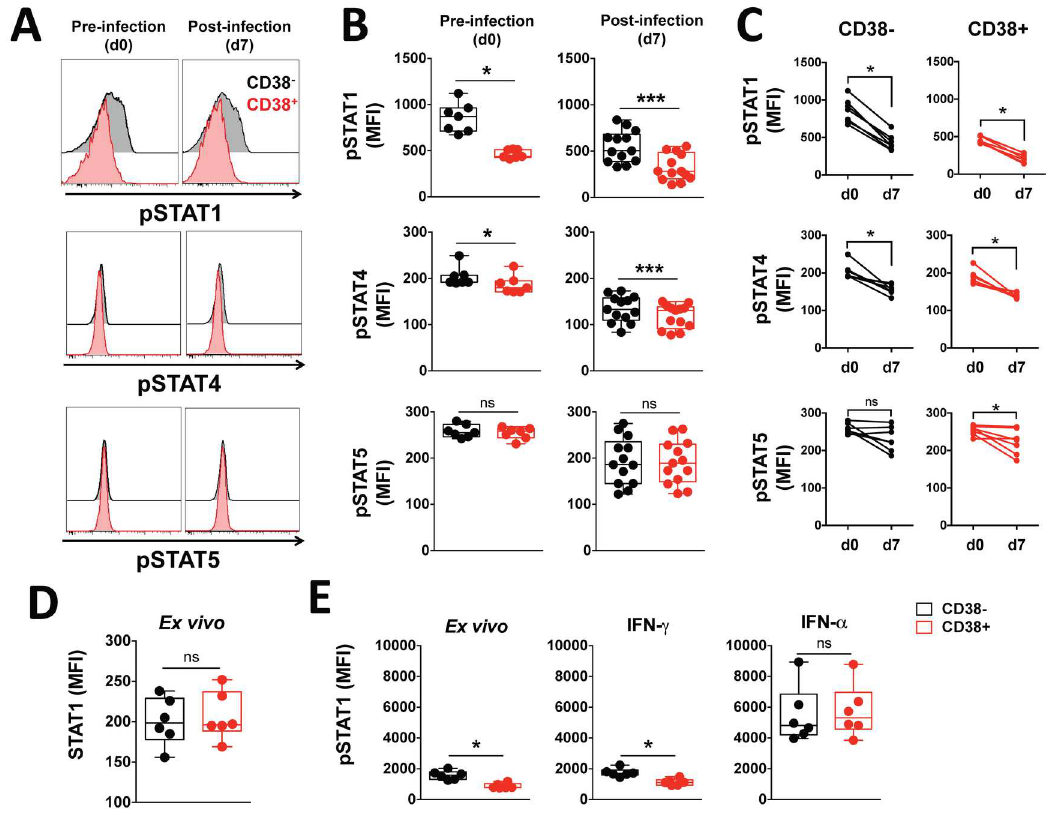
Fig 6. CD38 + CD4 + T cellshave a different STAT phosphorylation profile compared to CD38 - CD4 + T cells.(A) Representative stainingof one volunteer and (B-C) the expression levels of pSTAT1, pSTAT4 and pSTAT5 in CD38 - (black) or CD38 + (red)CD4 + T cells measured ex vivo by phospho-epitope specific flow cytometryin volunteers priorto and seven days post infection. (D) The expression level of total STAT1 proteinin CD38 - (black) or CD38 + (red)CD4 + T cells fromhealthy uninfected volunteers measuredby flow cytometry. (E) The expression level of pSTAT1 in CD38 - (black) or CD38 + (red)CD4 + T cells fromhealthy uninfected volunteers measuredby phospho-epitopespecific flow cytometry ex vivo or after15 mins stimulation with 100 ng/mLhuman recombinant IFN- γ or IFN- α measuredby phospho- epitopespecific flow cytometry. Differences between CD38 - and CD38 + CD4 + T cells and between priorto and seven days post infection were determinedwith the non-parametricWilcoxon test;box and whisker plots indicate median, interquartilerange and min-max.Graphs show combined data from(A-C)seven volunteers fromone cohort(pre)and 13 volunteers fromtwo separatecohorts(post),(D-E)six healthy controls. * , p < 0.05; *** , p < 0.001 ns, p >